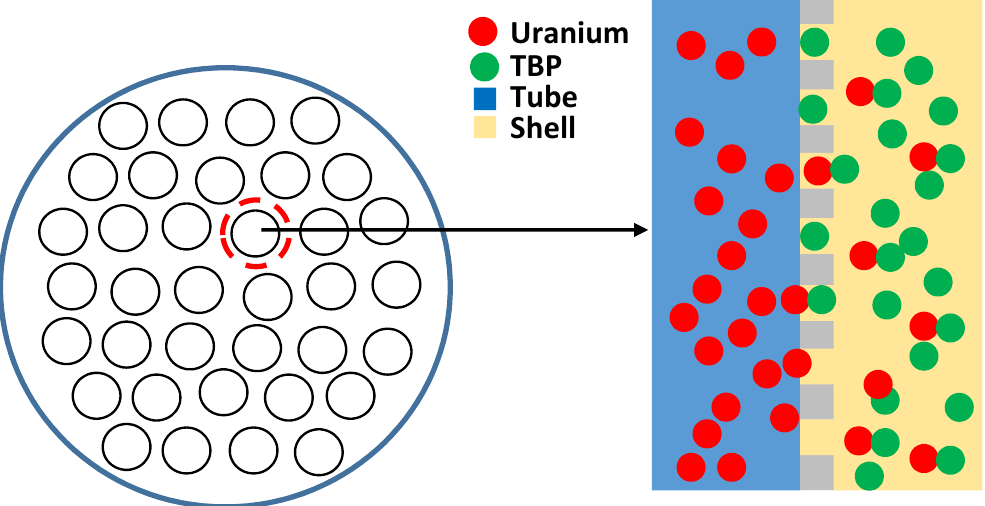
Figure 1. Schematic of membrane extractor for the uranium extraction using